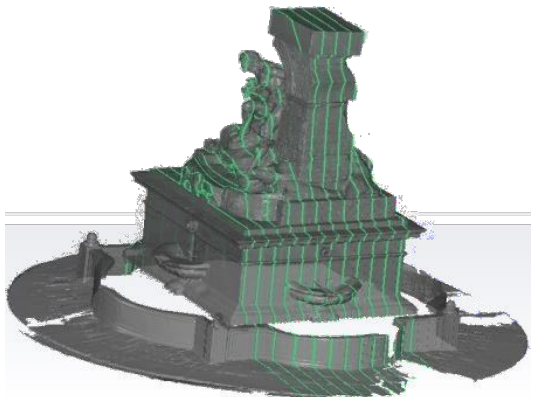
Figure 3. Sections following the Z axis